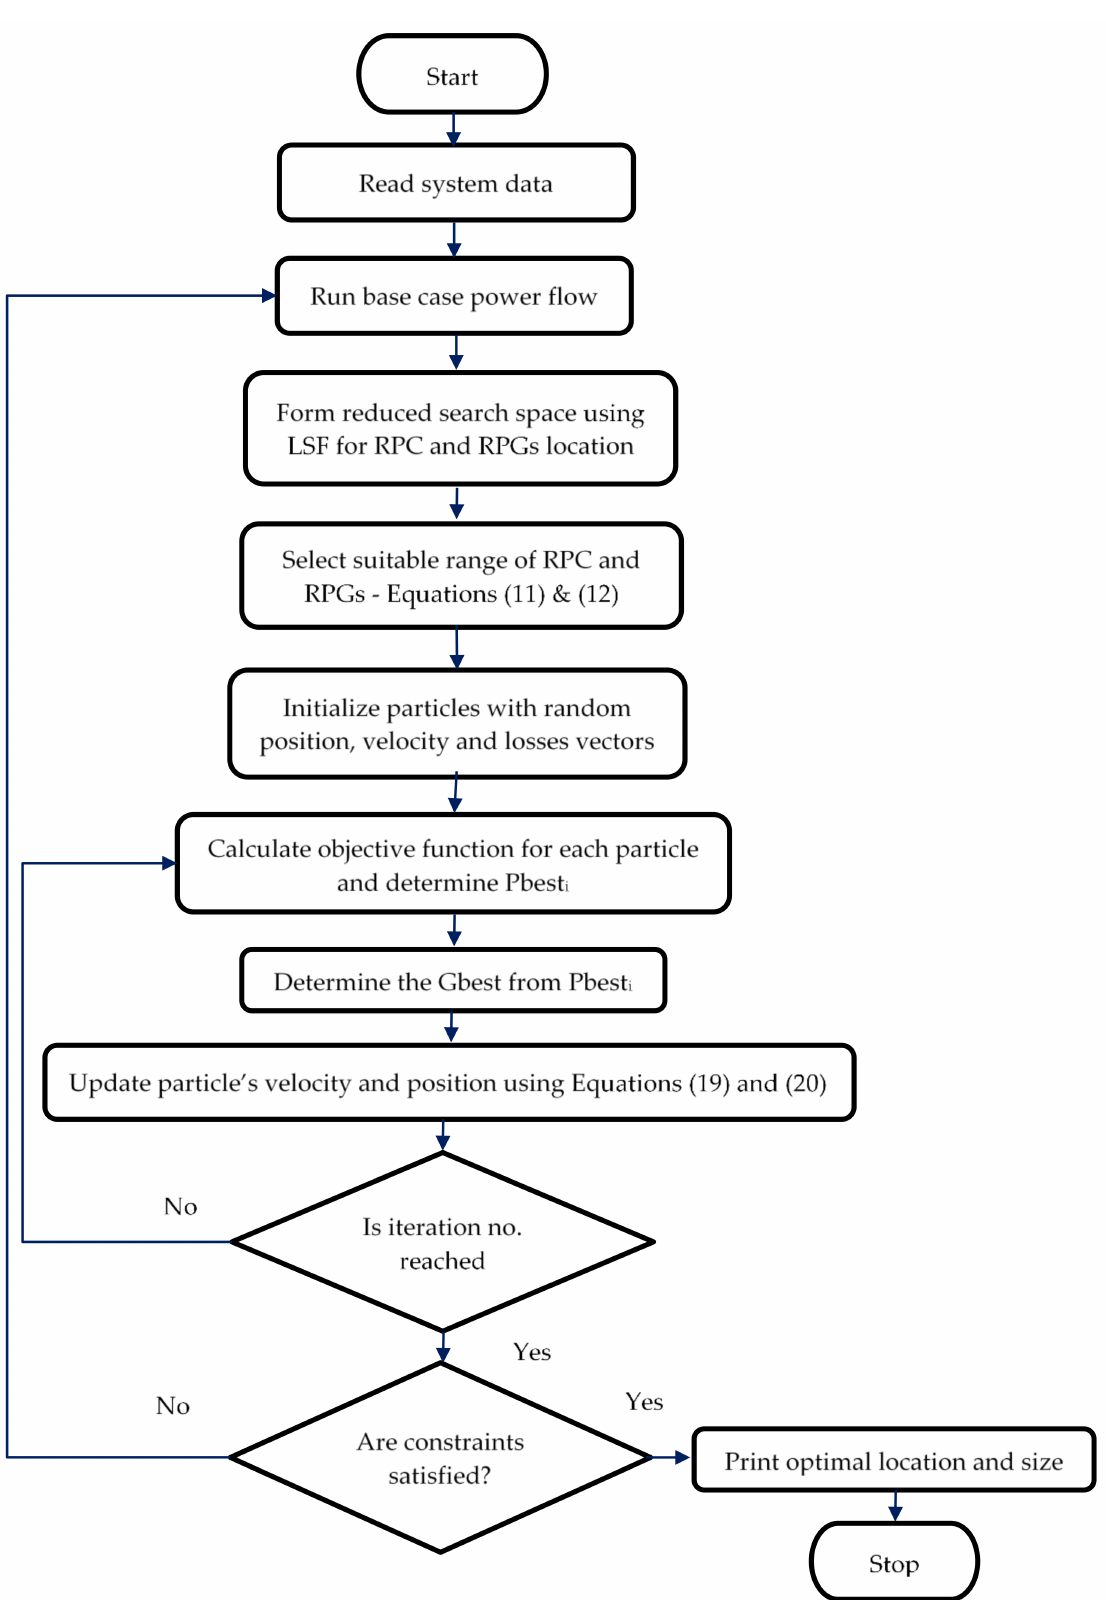
Figure 2. Flowchart of the proposed technique for positioning and sizing of RPGs and